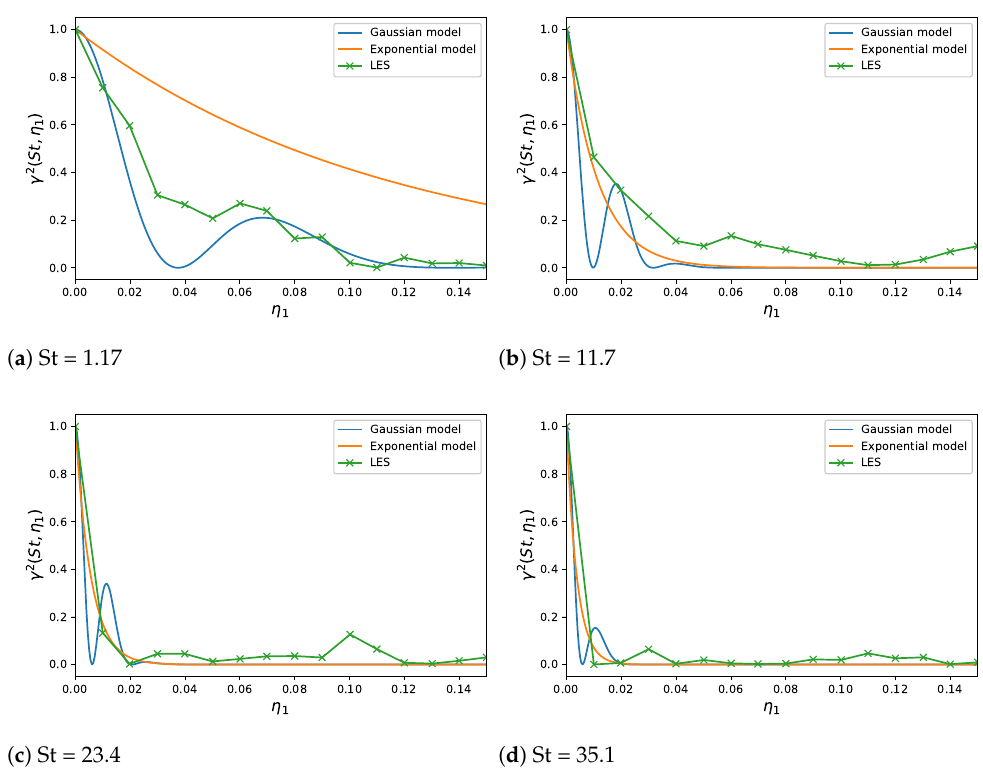
Figure 17. Examples of prediction of the longitudinal coherence function for various Strouhal numbers by means of the analytical model based on Equations (8), (14) and (19). Comparison with the empirical exponential decay model by Blake.